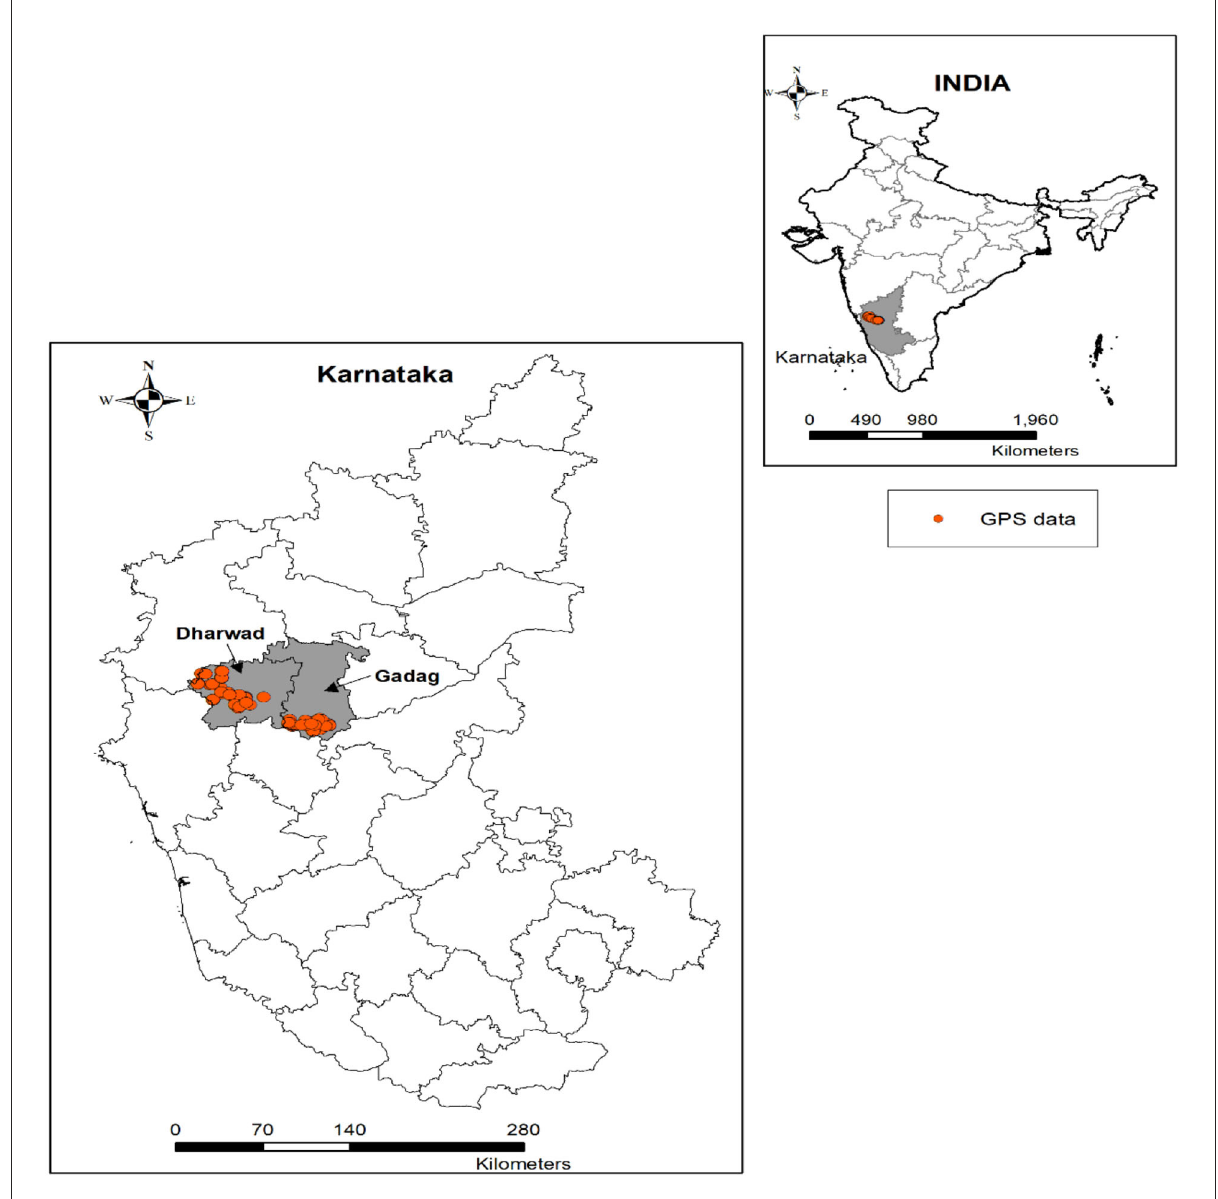
FIGURE1 Location of the study